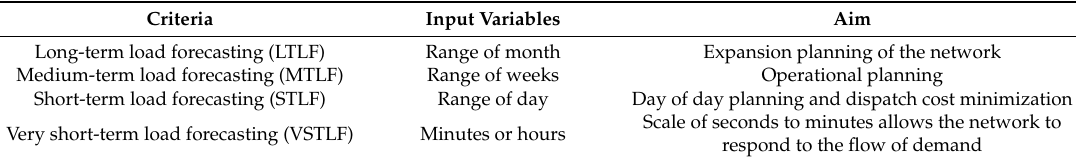
Table 1. Classification of electricity demand by four